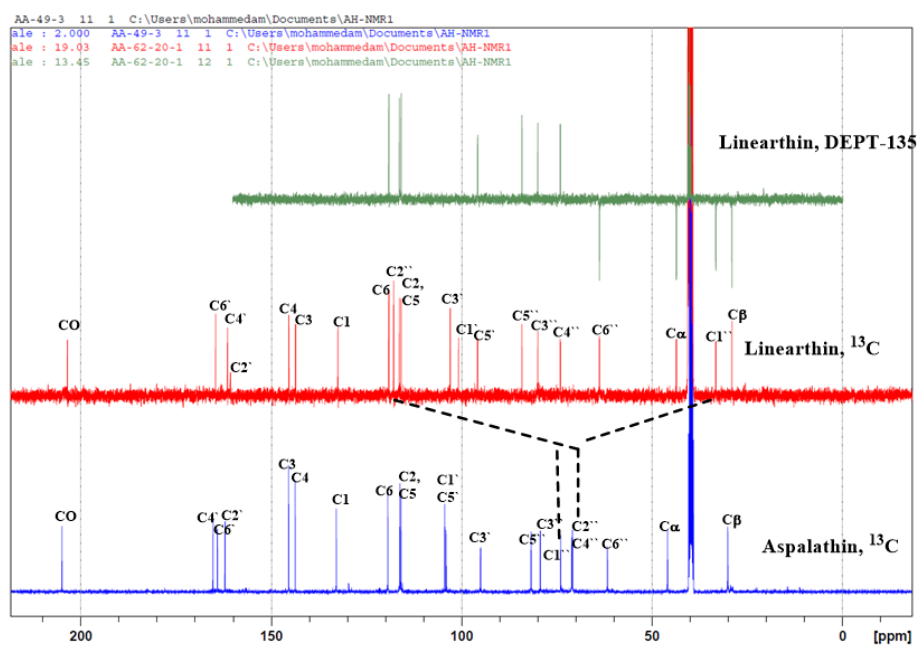
Figure 2. Comparisons of carbon-13 and DEPT-135 between linearthin ( 1 ) and aspalathin ( 2 ). The 2D NMR spectra fully established the structure of compound 1 , in particular, the HMBC correlations spectrum (Figure 1) which showed cross-peaks between H-5 ′ /C-1 ′ , C-3 ′ , C-6 ′ , C-4 ′ ; H-1 ″ /C-2 ′ , C-3 ′ , C-4 ′ , C-2 ″ , C-3 ″ ; H-2 ″ /C-4 ″ ; H-4 ″ /C-2 ″ , C-6 ″ ; H-5 ″ /C-3 ″ , C-6 ″ ; 5 ′ -OH/C-1 ′ , C-2 ′ , C3 ′ among others and confirmed the structure as shown in Figure 1. This compound was given the trivial name linearthin. The relative configuration of the sugar moiety was established from 1 H- 1 H couplings and NOESY spectra of the heptaacetate de- rivative 1a . The spectra from the original compound 1 could not be interpreted because of the complexity of the sugar proton area. The NOESY spectrum of the heptaacetate deriv- ative showed a typical fructofuranoside configuration and showed correlations between H-1 ″ , H-3 ″ and H-5 ″ ; and confirmed the syn -relationship and the spiral linkage at C-2 ″ , while H-4 ″ showed a correlation with H-6 ″ . Attempts to crystalize the acetate derivative to establish the absolute configuration of the isolated compounds were not successful. To the best of our knowledge and according to the SciFinder database, linearthin ( 1 ) has not been previously isolated before from a natural source, and it represents a very rare skele- ton type containing a C -fructofuranoside unit. Table 1. 1 H- and 13 C-NMR data for compounds 1 – 3 . Posi- tion